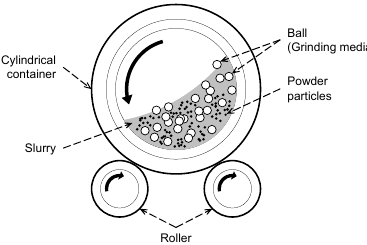
Figure 1. Simplified schematic diagram for the target ball mill. Adapted from FIGURE 12.11 in [18], with the permission of ASM International. Processes 2020 , 8 , x FOR PEER REVIEW